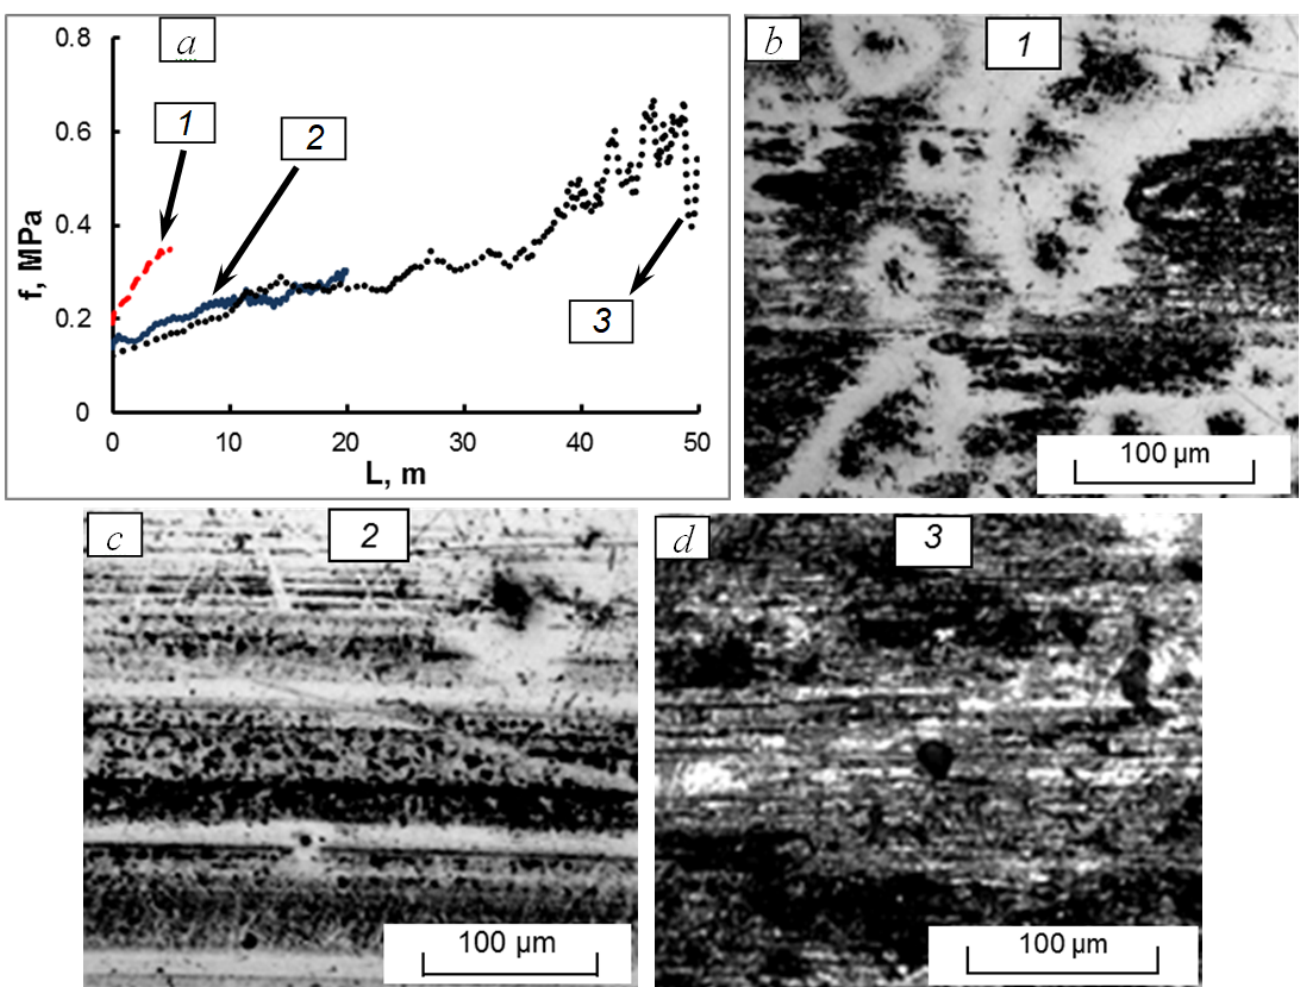
Figure 8. Effect of sliding distance on the value of specific friction force of the ECAP(A)-ed Al-30Sn sample ( a ) and the structure of the friction track surface ( b , c ) under dry friction contact; P = 1 MPa; V sl = 0.07 m/s. Sliding distance: 5 m ( 1, b ); 20 m ( 2, c ); 50 m ( 3, d